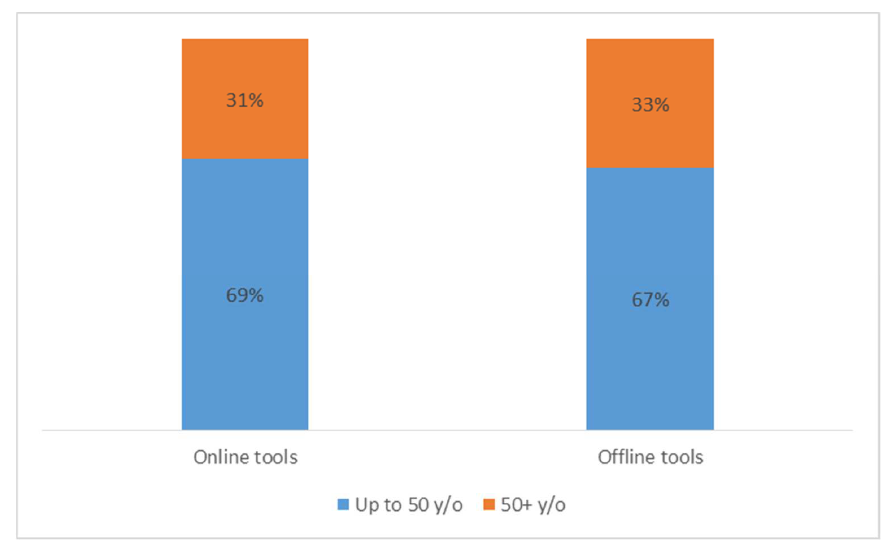
Figure 4. What kind of tools do you use in your work? N = 147.